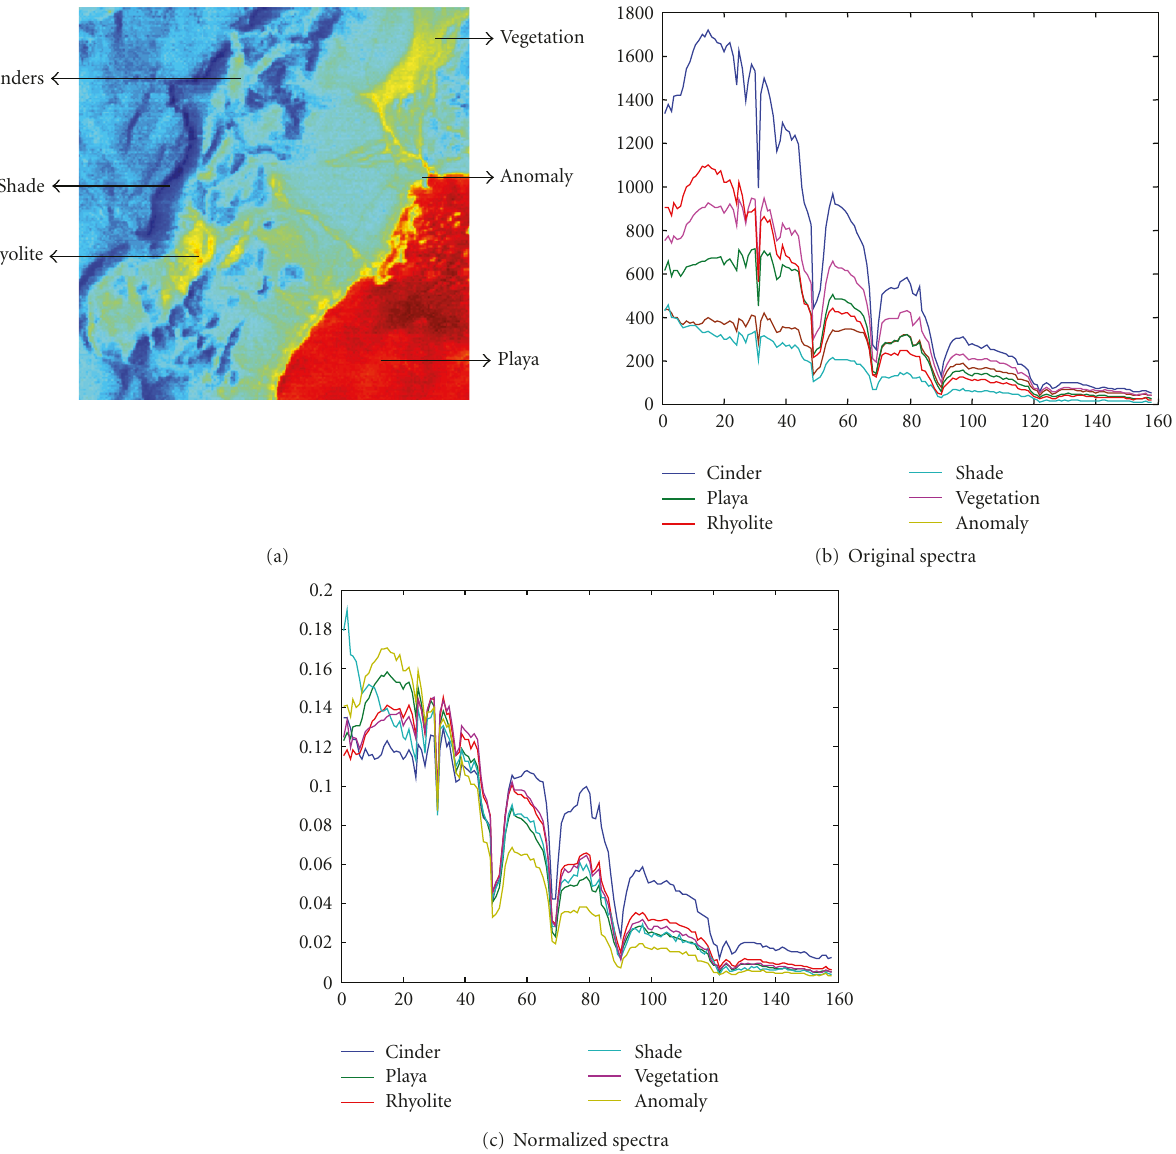
Figure 28: AVARIS LCVF scene.